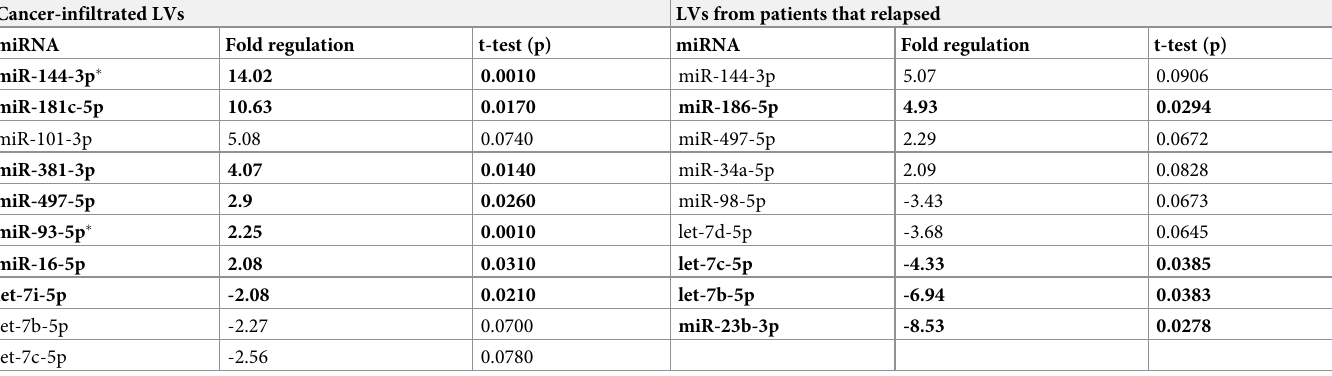
Table 5. Differential expression of miRNA between cancer-infiltrated versus non-cancer infiltrated LVs and LVs from relapse versus non-relapse patients within 13.2 ± 6 months. Cancer-infiltrated